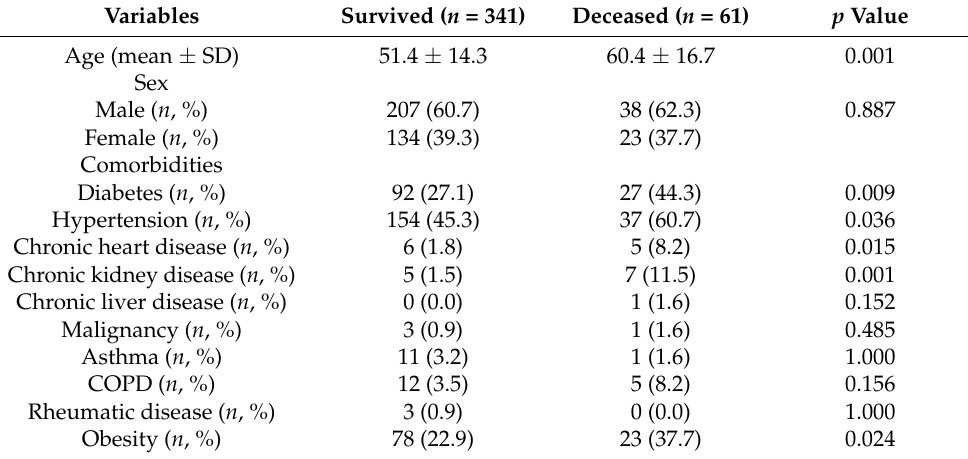
Table 1. Baseline characteristics of the patients included in the study according to the outcome.